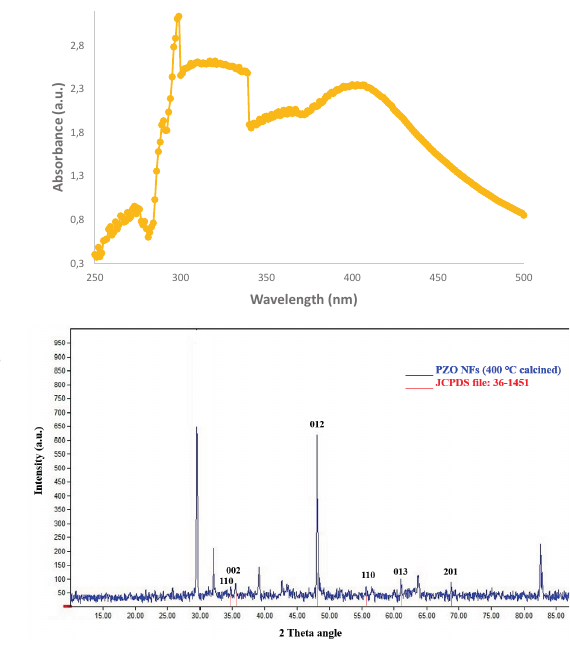
Figure 2: a ) UV-Vis spectrum, b) XRD pattern of ZnO nano